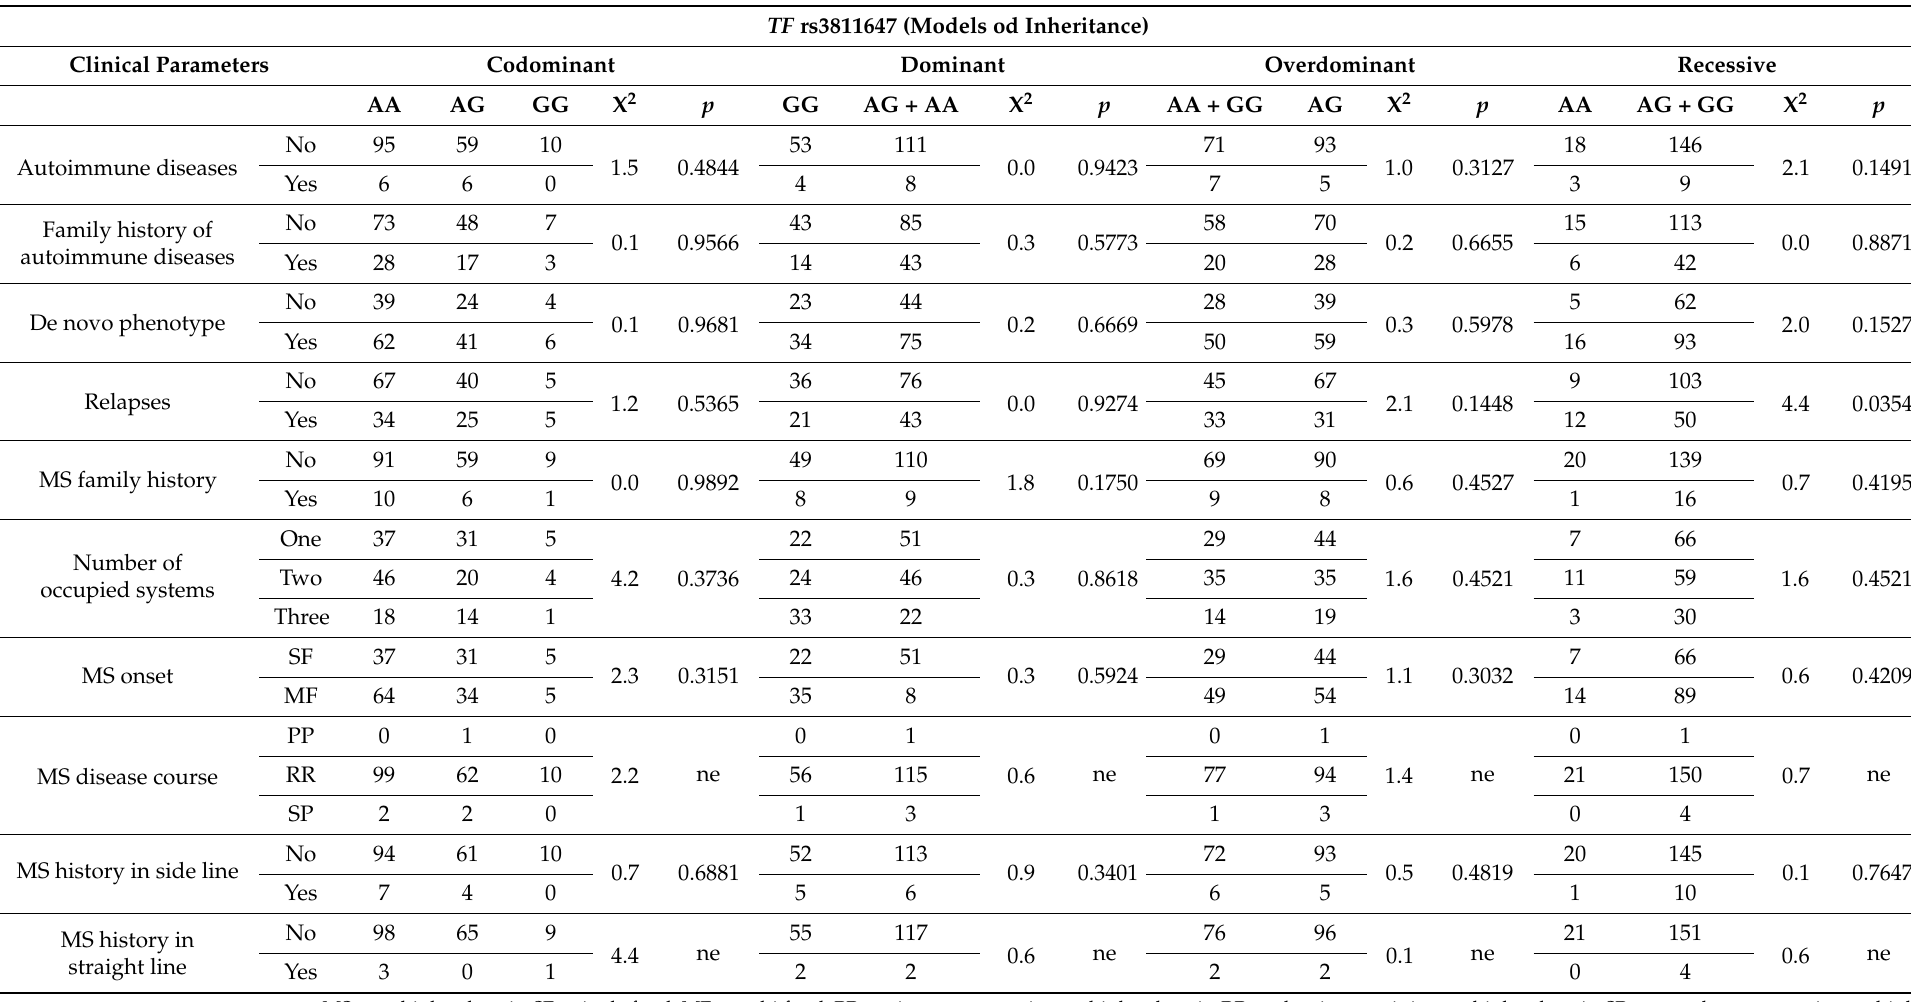
Table 9. Analysis of the relationship between the rs3811647 TF polymorphism and selected clinical parameters. TF rs3811647 (Models od